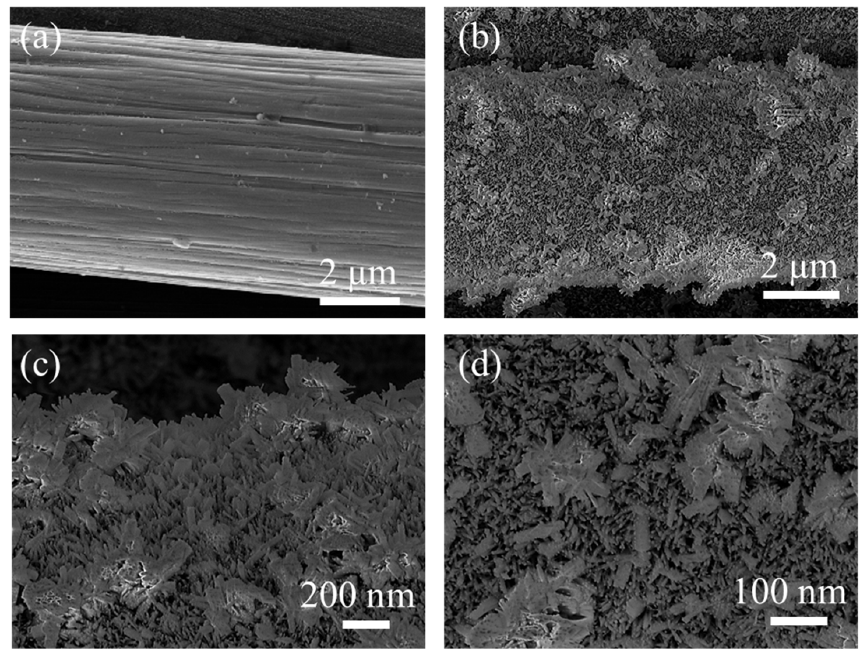
Figure 2. Morphological characteristics of ZnO@CFT electrode: ( a ) SEM image of pristine CFT and ( b ) a low-resolution FE-SEM image. ( c ) A high-resolution FE-SEM image and ( d ) a section from Figure c.